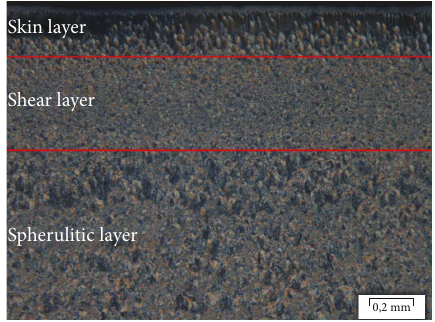
Figure 10: Layer structure of the injection-molded Tenac plates (PLM image of “ Tenac_IM_90 ° C-MT_S1 ”